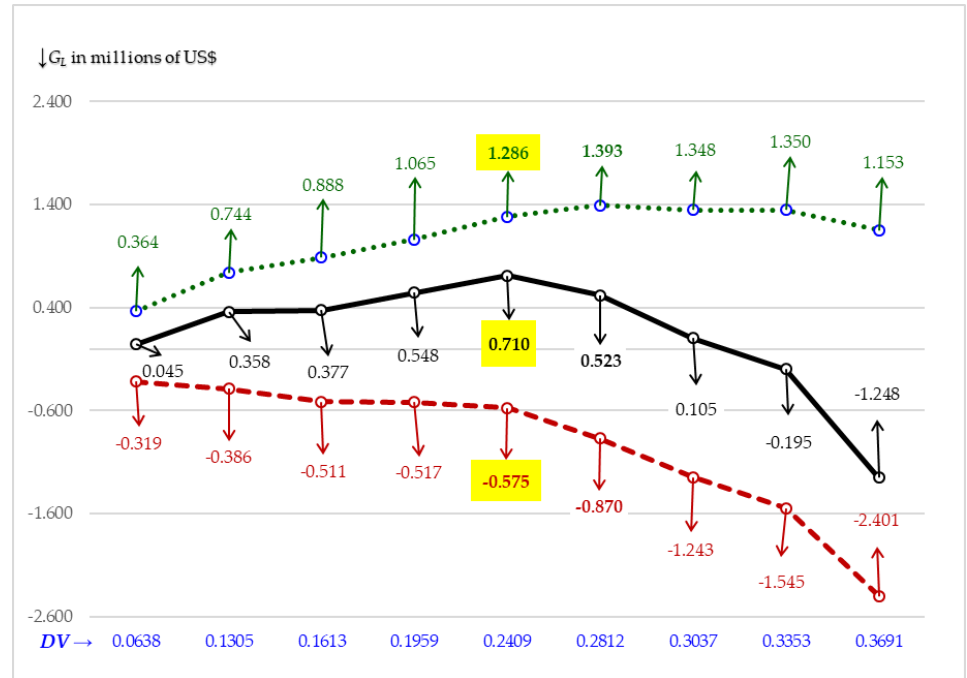
Figure 1. Nongrowth Pass-Through Gain to Leverage ( G L ) Versus debt-to-firm value ratios (DVs) under Tax Cuts and Job Acts (TCJA) with g L of 0% and optimal credit rating ( OCR ) of A3. Gain to Leverage ( G L ), solid line; 1st Component, dotted line, and 2nd Component, dashed